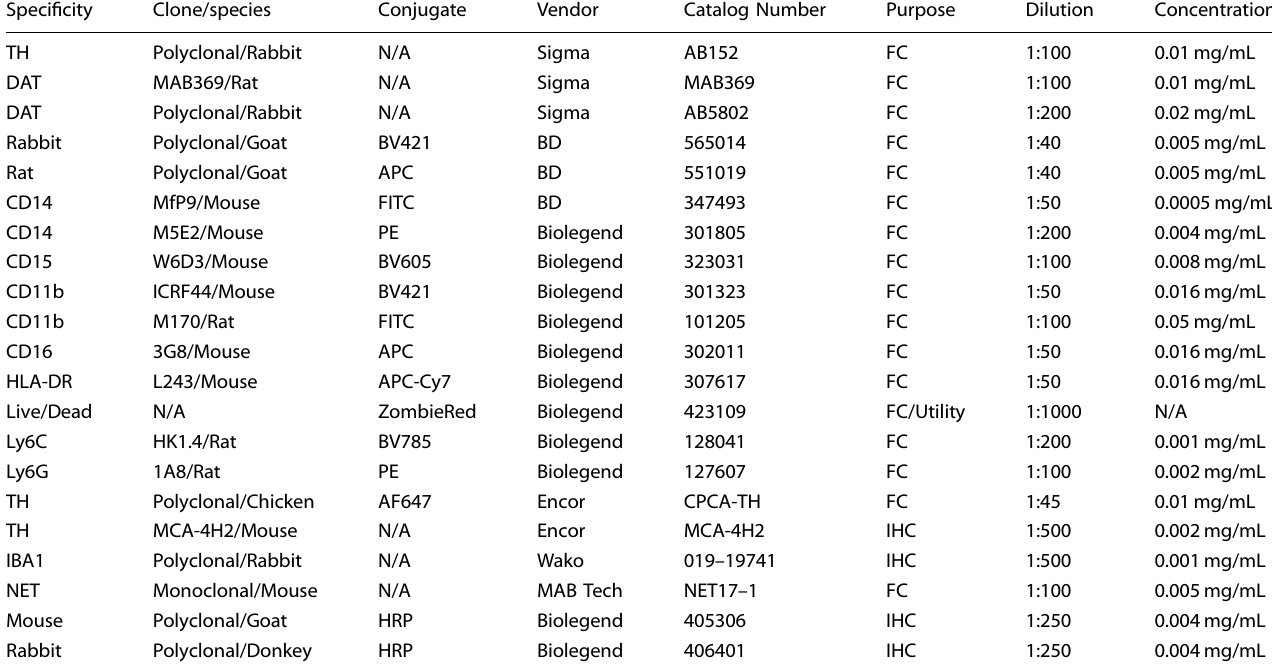
Table 1. Antibodies.